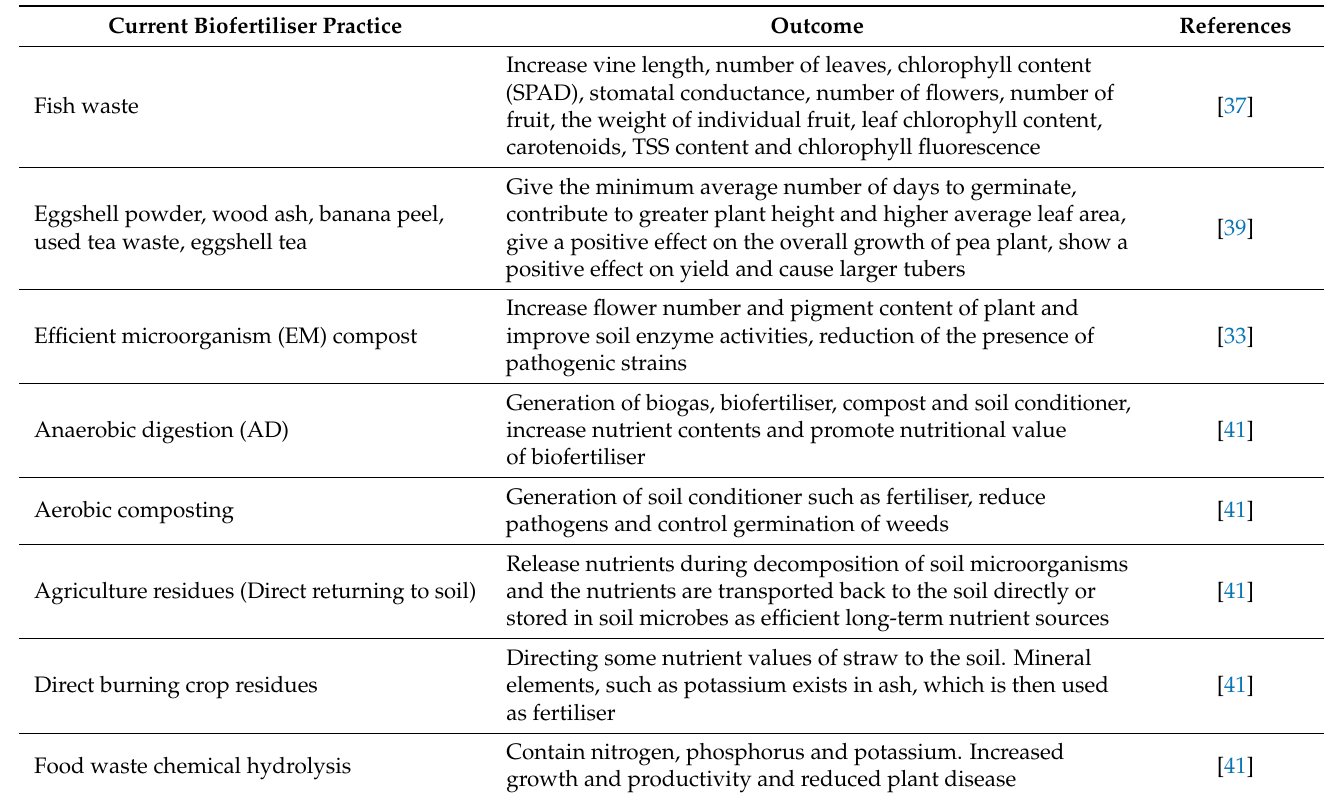
Table 1. Current practices and advances of